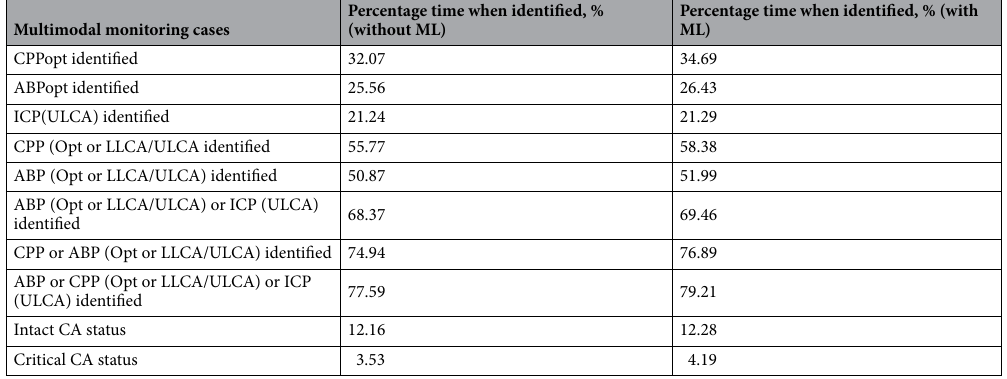
Table 3. Percentage time of multimodal monitoring cases when CPPopt, ABPopt, and LLCA/ULCA are identified. Here, CA is the cerebrovascular autoregulation, ICP is the intracranial pressure, ABP is the arterial blood pressure, CPP is the cerebral perfusion pressure, ULCA is the upper limit of cerebrovascular autoregulation, LLCA is the lower limit of cerebrovascular autoregulation, Opt is the optimal value, and ML represents machine learning.